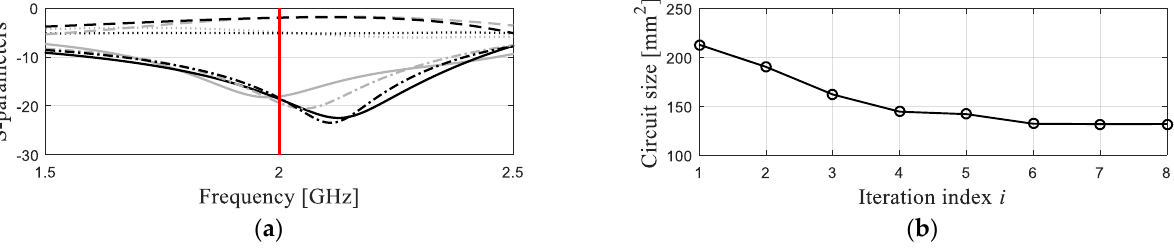
Figure 7. Circuit IV: ( a ) responses at the initial ( A 0 = 213 mm 2 ) and design optimized using the pro- posed algorithm (reduced size: A opt = 132 mm 2 ), indicated using gray and black, respectively; S - parameters marked as | S 11 | ( — ), | S 21 | (····), | S 31 | (- - -), | S 41 | (- .); the vertical line marks the circuit operating frequency; ( b ) evolution of the circuit size throughout the optimization run.